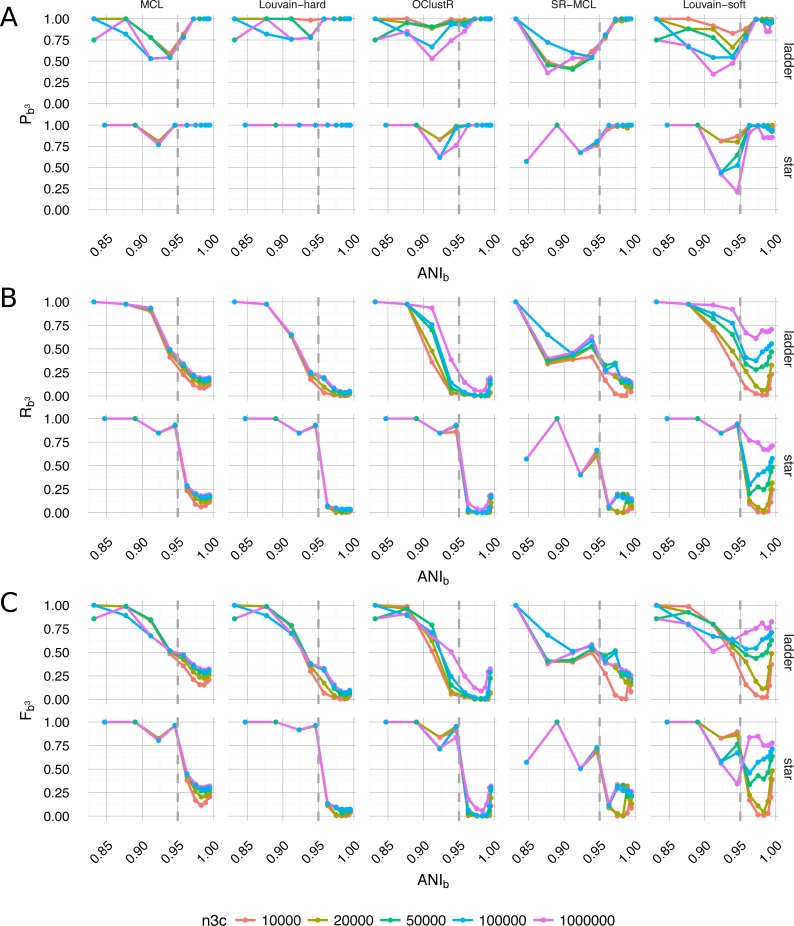
Performance of the five clustering algorithms (MCL, Louvain-hard, OClustR, SR-MCL, Louvain-soft), as measured by weighted extended Bcubed precision Pb3 (A), recall Rb3 (B) and their harmonic mean Fb3 (C) (Eqs. 1–3).The slice from the sweep pertained to uniform abundance and 100×WGS coverage and the best performing runtime parameters specific to algorithms (i.e., for MCL and SR-MCL inflation = 1.1). (A) Louvain-hard demonstrated high precision throughout, while our simple modification Louvain-soft lead to a drop, particular in the region of intermediate evolutionary divergence. (B) All algorithms struggled to recall the four individual genomes as evolutionary divergence decreased and cluster overlap grew. Within the region of overlap, Louvain-soft performed best and clearly benefited from increasing the number of HiC/3C read-pairs (n3c: 104 − 106). (C) In terms of Fb3, the harmonic mean of Recall and Precision, only Louvain-soft appeared to be an appropriate choice when it might be expected that strain-level diversity exists within a microbial community.